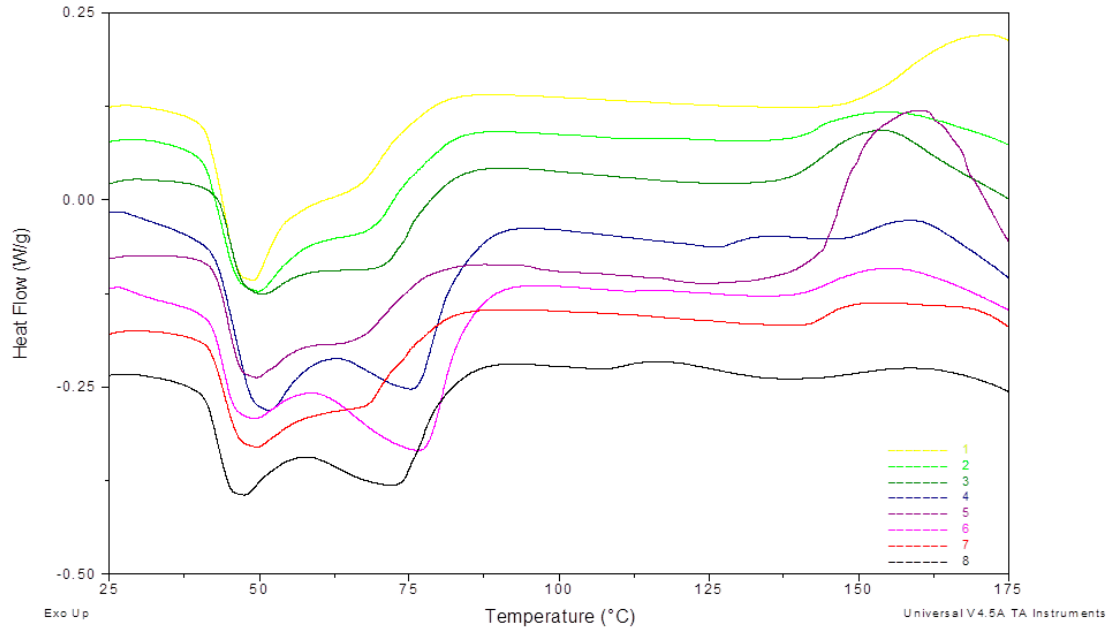
Figure 4. Di ff erential scanning calorimetry (DSC)—heat flow results from the first Figure 4. Differential scanning calorimetry (DSC)—heat flow results from the first cycle.